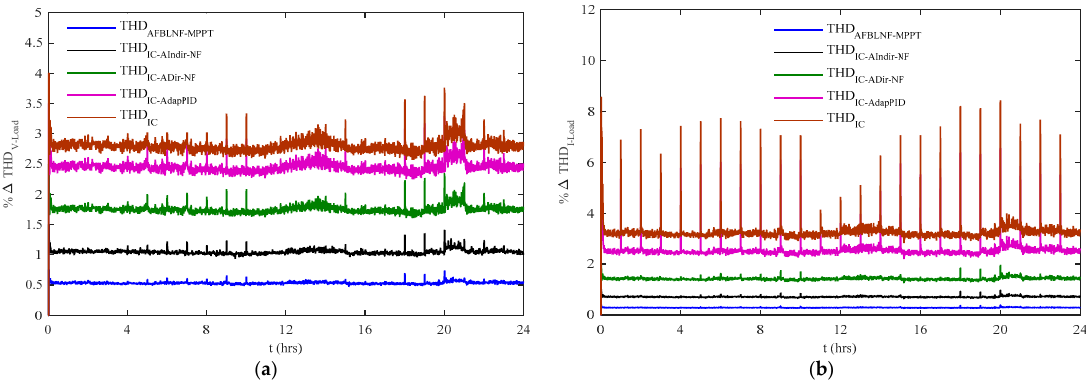
Figure 10. % change in load ( a ) voltage total harmonic distortions (THD) ( b ) current THD.